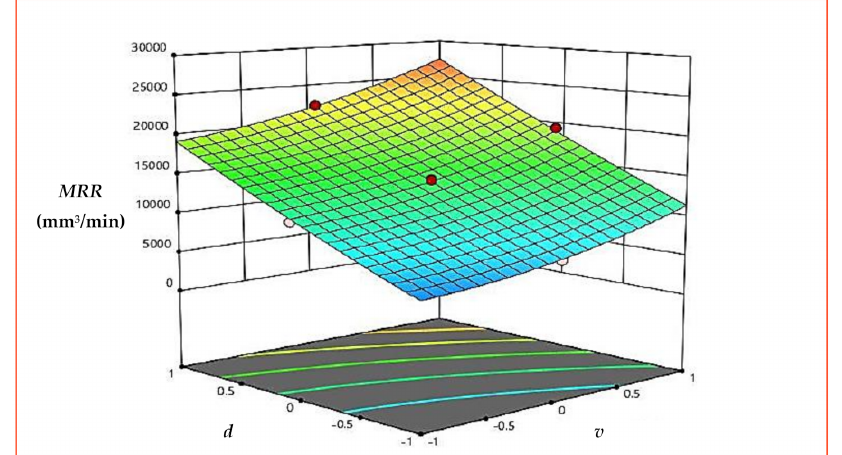
Figure 7. 3D surface plot for MRR ( v × f ).